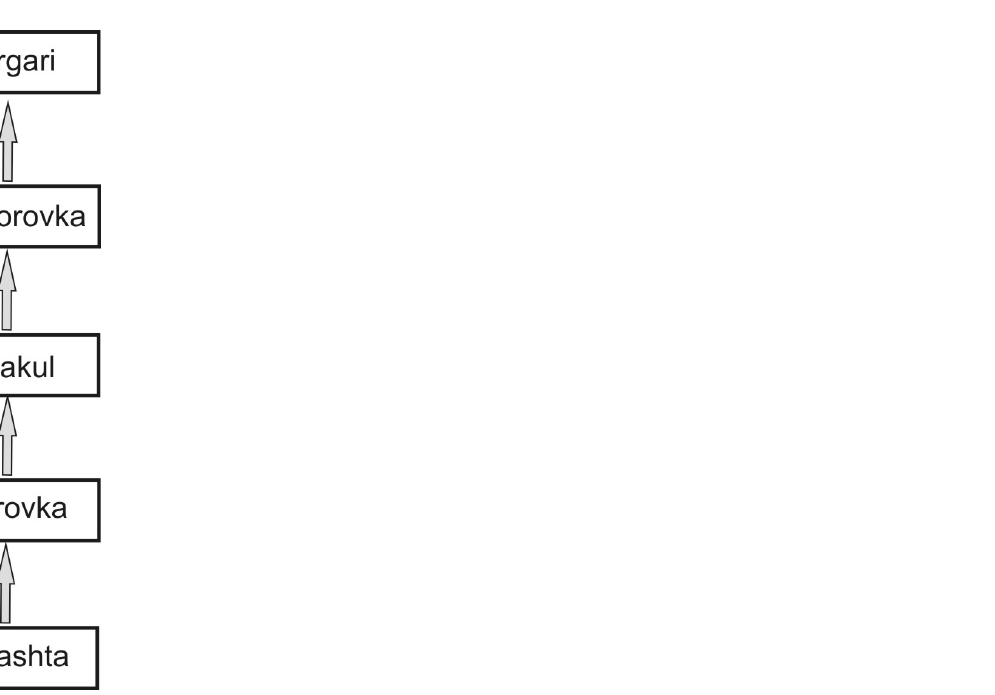
Figure 13: Scheme of G.B. Zdanovich (1973, 1988) with the genetic continuity of the Andronovo